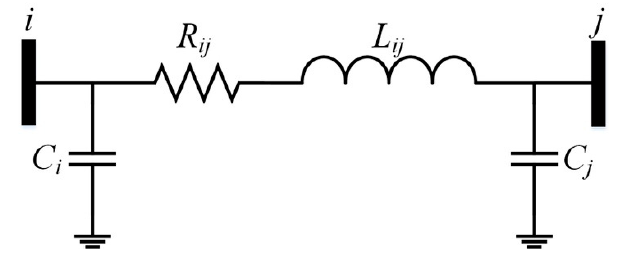
Figure 4. π -equivalent model of line connecting nodes i and j of the electrical network.